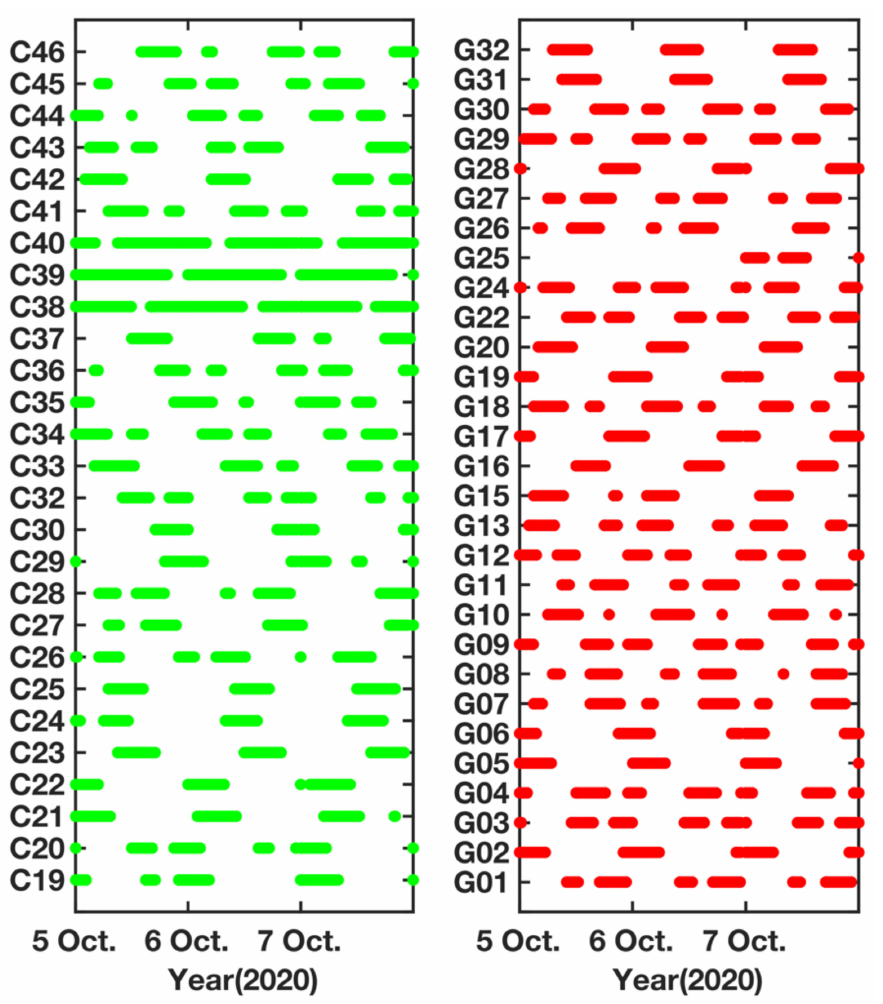
Figure 2. The availability of PPP-B2b orbit/clock corrections for BDS-3/GPS satellites from 5